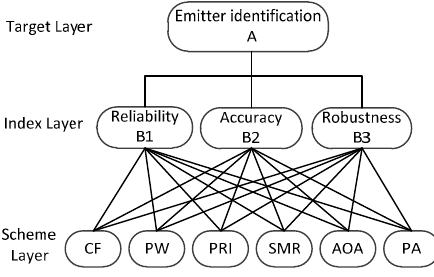
Figure 6. Evaluation system model.